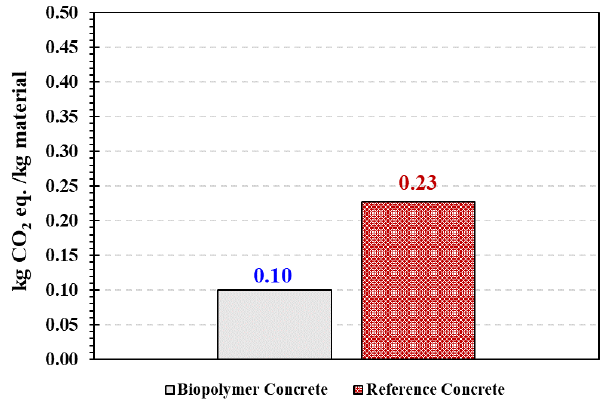
Figure 16. Carbon footprint analysis comparing BPC to reference cement concrete.